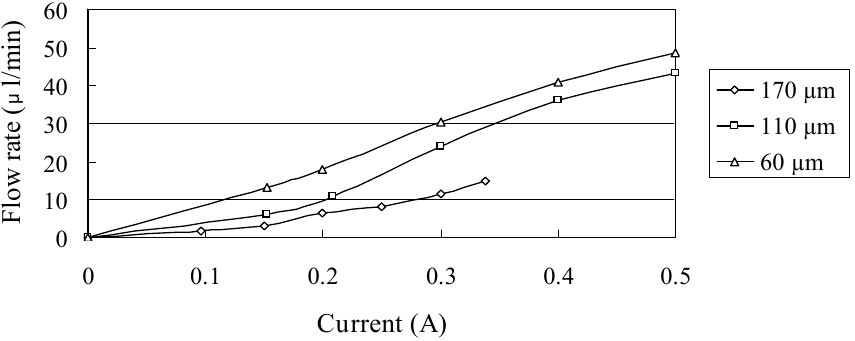
Figure 9. Variation of flow rate with input current as function of magnetic layer thickness at constant actuation frequency of 240